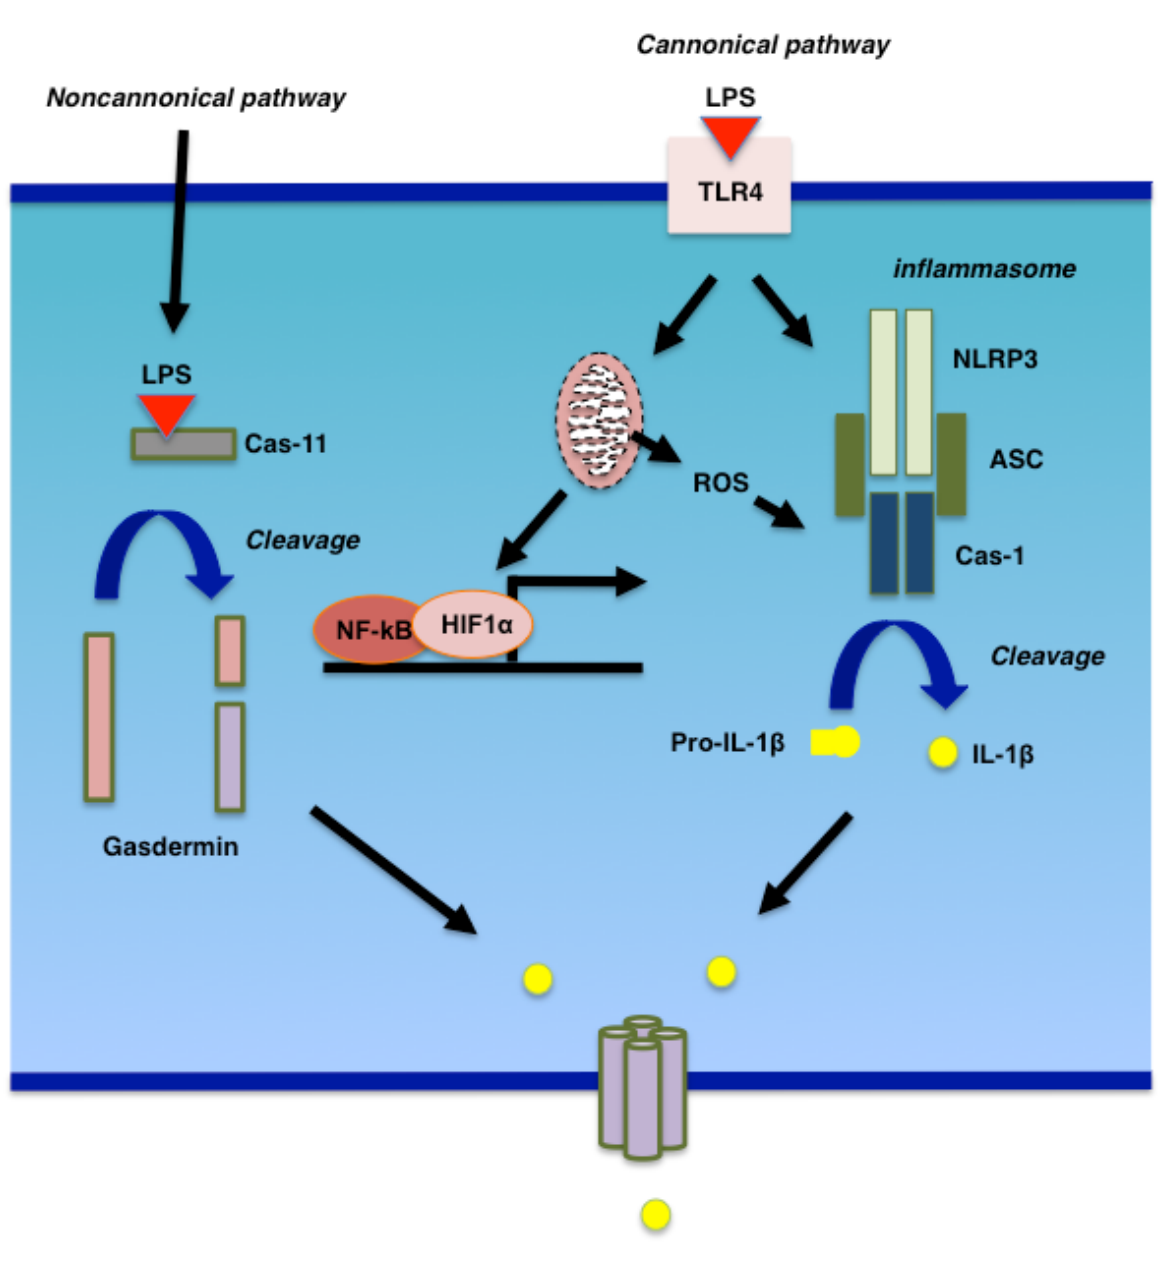
FIGURE 2: Cytokine secretion in response to LPS stimulation. There are two pathways for the LPS-initiated secretion of cytokines. In the conventional pathway, LPS binds to its cognate cell surface receptor, TLR4. The activation of TLR4 leads to the activation of NF-kB as well as HIF1α, the latter of which is mediated by mitochondrial dysfunction. Both NF-kB and HIF1α are involved in the expression cytokines as well as inflammasome components. Inflammasomes, comprising NLRP3, ASC, and Cas-1 for example, are involved in the activation of Cas-1. In an unconventional pathway, LPS binds directly to cytoplasmic Cas-11, which cleaves gasdermin to form a pore in the plasma